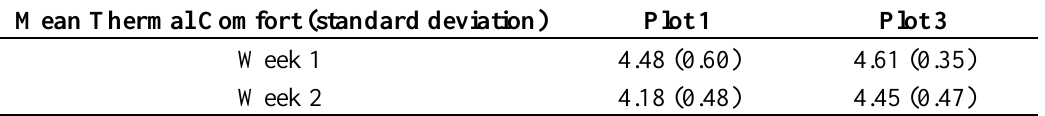
Table 7. Mean comfort levels SC5 week 1 and week 2.